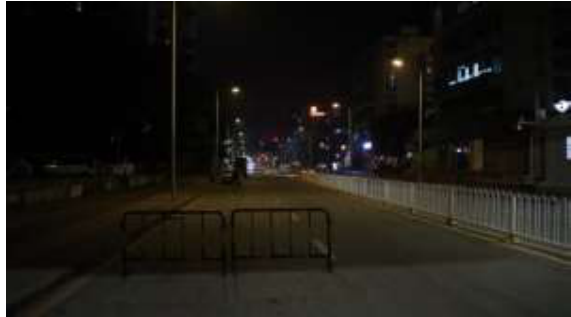
Figure 9. Measurements conducted in a typical road in Shenzhen with a length of 140 m and a width of 16 m.